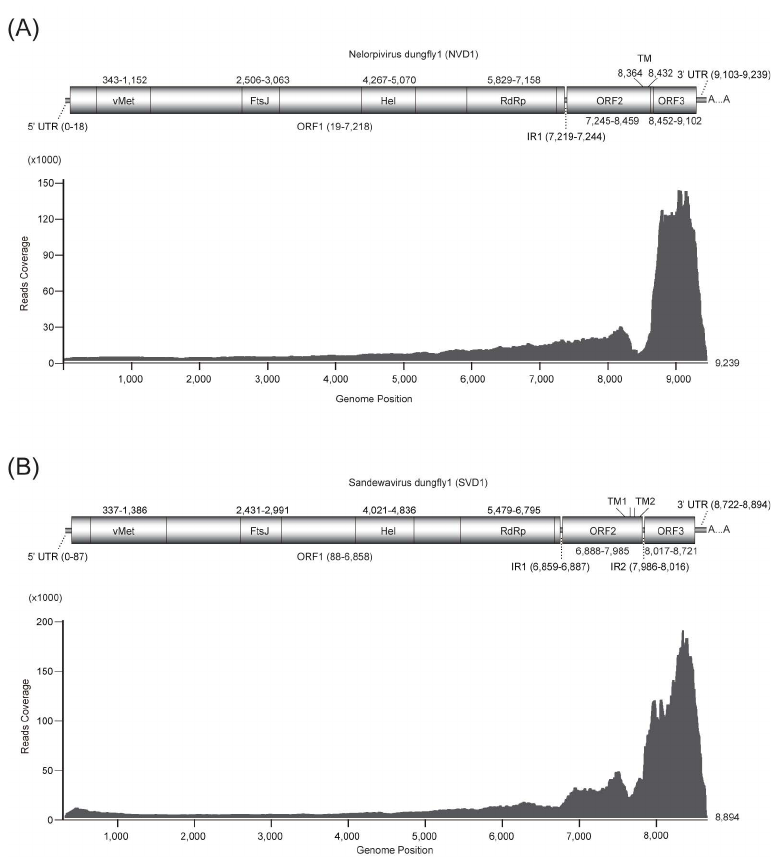
Figure 1. Genome organization and transcriptome raw read coverage of Nelorpivirus dungfly1 ( A ) and Sandewavirus dungfly1 ( B ). vMet, viral methyltransferase domain; FtsJ, RNA ribosomal methyltransferase domain; Hel, viral helicase domain; RdRp, RNA-dependent RNA polymerase domain; UTR, untranslated region; IR, intergenic region; TM, transmembrane domain; TM1 region, 7743–7811; TM2 region,